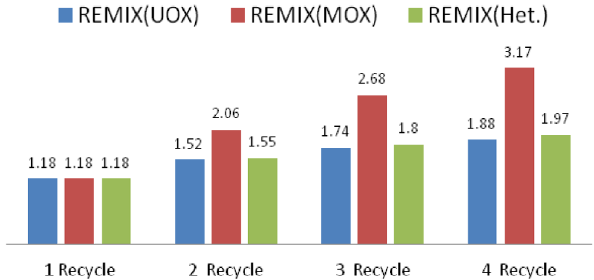
Fig. 6. Integral plutonium content for the core fuel loading, %.